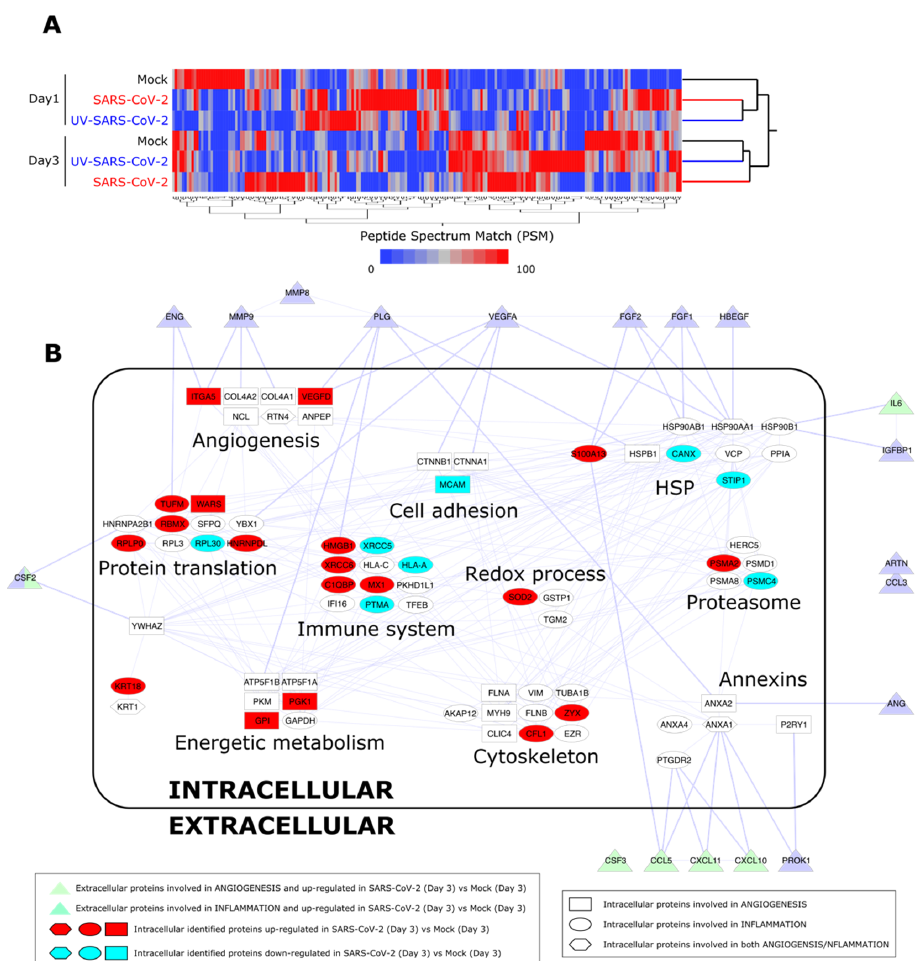
Figure 5. Proteome analysis of SARS-CoV-2-infected HL-mECs. ( A ) Hierarchical clustering of HL-mEC proteomes at day 1 and 3 p.i. The dendrogram was obtained by computing the average peptide spectrum matches (aPSM) of the 214 DEPs selected by LDA and MAProMa software; the Euclidean distance metric and Ward’s method were applied (JMP15.2 software) with DAve index > 0.3. ( B ) PPI network at day 3 p.i. of DEPs involved in angiogenesis and inflammation. The interactome network (91 nodes and 262 edges) was built through the mapping of intracellular proteins found differentially expressed by proteomics and extracellular proteins assayed by angiogenic and inflammation array of SARS-CoV-2 vs. Mock HL-mECs. Physical or/and functional interactions connecting intra- and extra-cellular identified proteins are highlighted by thicker edges. Intracellular node color code indicates proteins up-regulated (in red) and down-regulated (in blue light) in SARS-CoV-2- vs. mock-infected HL-mECs. For more details see Materials and Methods Section